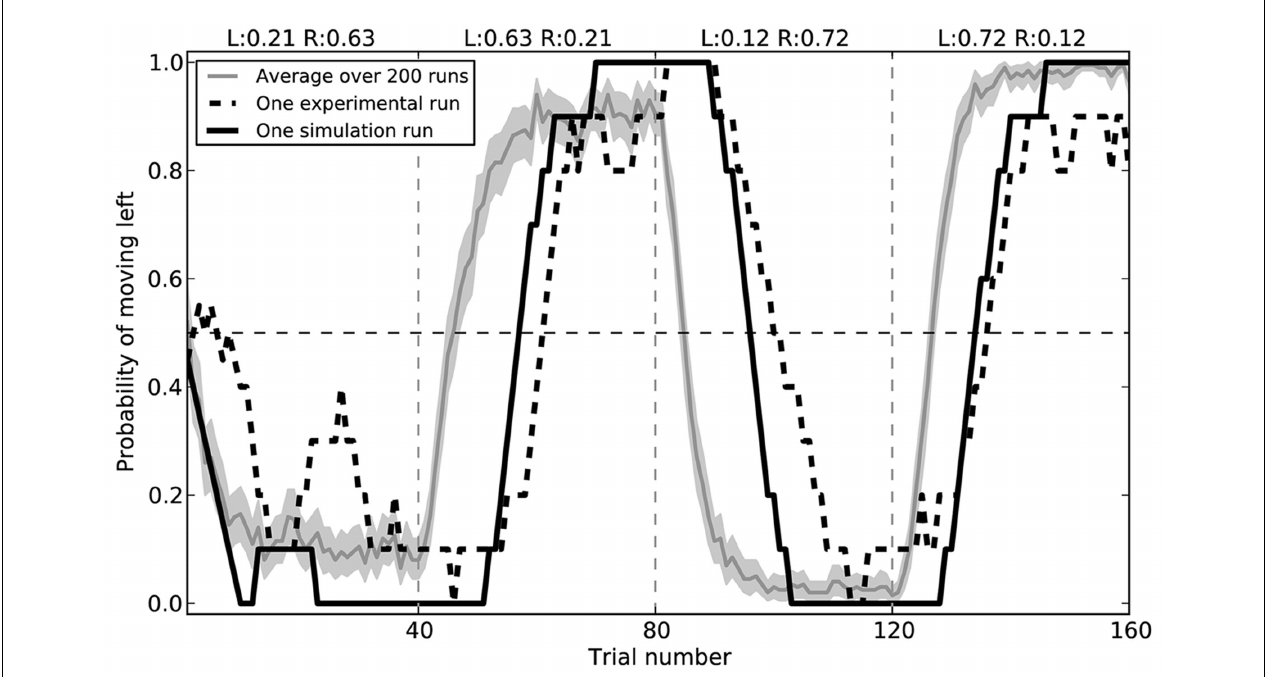
FIGURE 7 | Model performance compared to sample empirical data from Kim et al.’s (2009). Black lines show a single run, plotting the proportion of time the rat or the model chose to go left over 160 trials, averaged with a 10-trial window.The gray area gives the mean performance of the model over 200 runs, with 95% bootstrap confidence